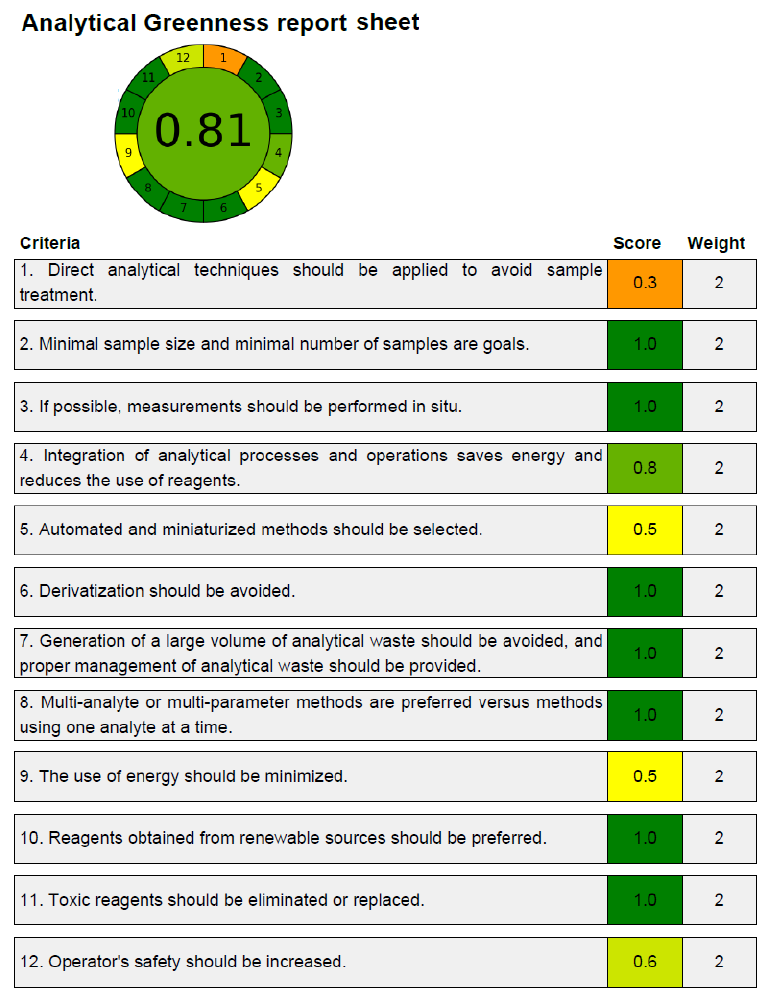
Figure 5. AGREE scale sheet presenting AGREE scale for 12 distinct components of GAC for the established HPLC methodology of CCM determination recorded using AGREE calculator.